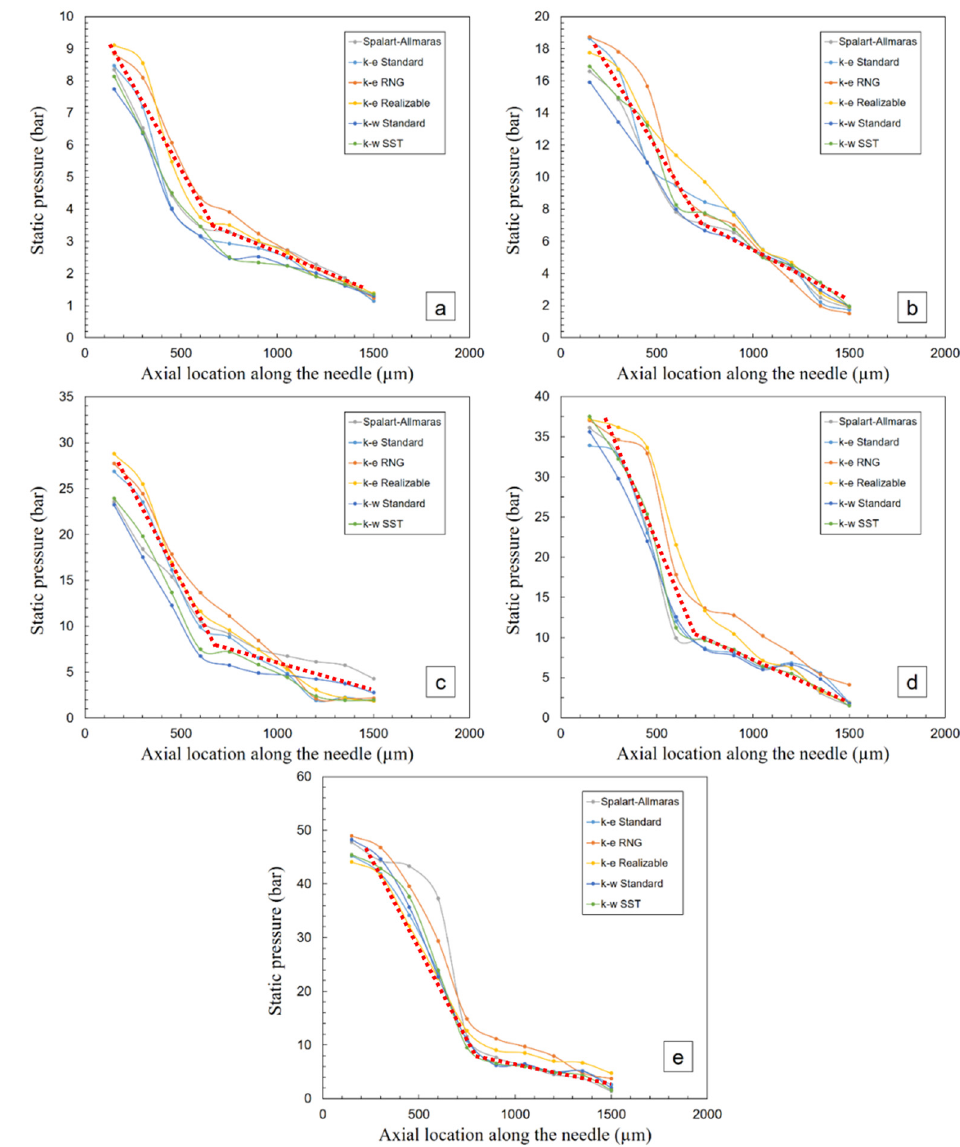
Figure 5. Calculated wall static pressures along the needle inside the orifice with a clearance of 300 µm at different upstream pressures of: ( a ) 10 bar; ( b ) 20 bar; ( c ) 30 bar; ( d ) 40 bar; and ( e ) 50